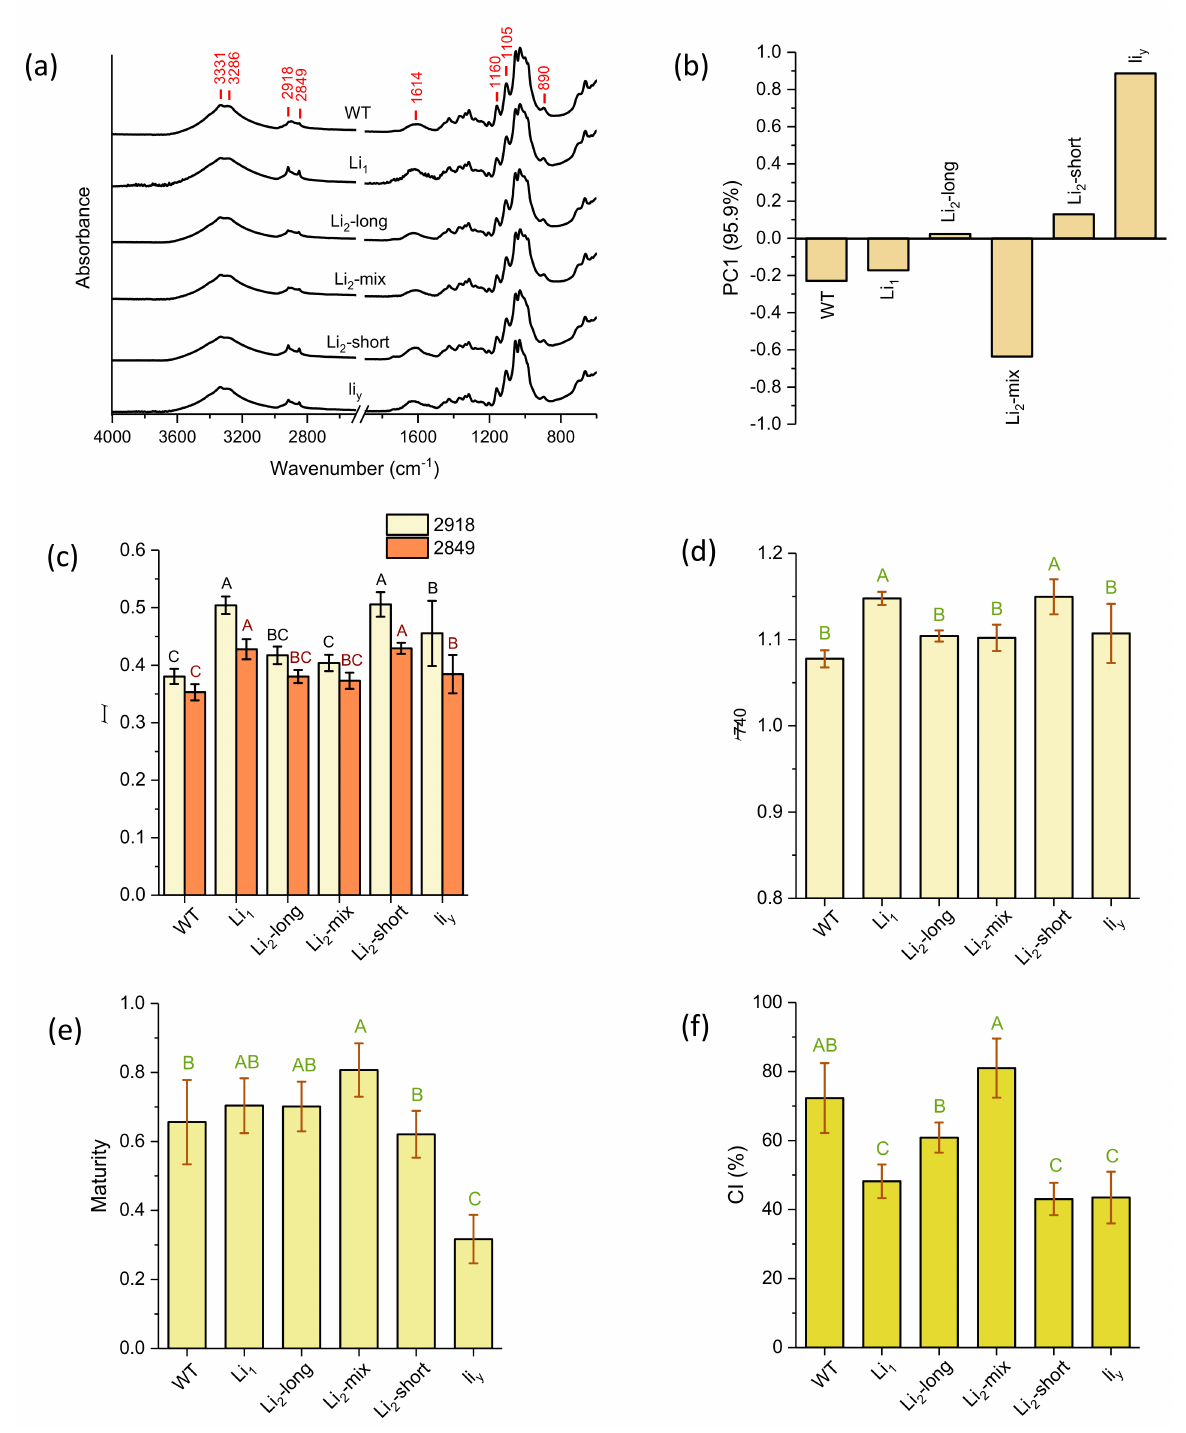
Figure 7. Attenuated total reflectance Fourier transform infrared (ATR FT-IR) spectra and relevant IR parameters of six cotton fiber samples. ( a ) Spectra; ( b ) the first principal component (PC1) scores of the six samples by PCA calculation of the normalized spectra; ( c ) the relative amounts of waxes semi-quantitatively measured by the normalized intensities of methylene peaks at 2918 and 2849 cm − 1 ; ( d ) the relative amount of amorphous cellulose linked to the normalized intensity at 740 cm − 1 ; ( e ) the IR-based maturity; and ( f ) IR-based cellulose crystallinity index (CI) calculated by three-band ratio algorithms. Data in the c–f are presented in average with SD bars ( n = 5). Different letters indicate the values of the same parameter significantly different at p ≤